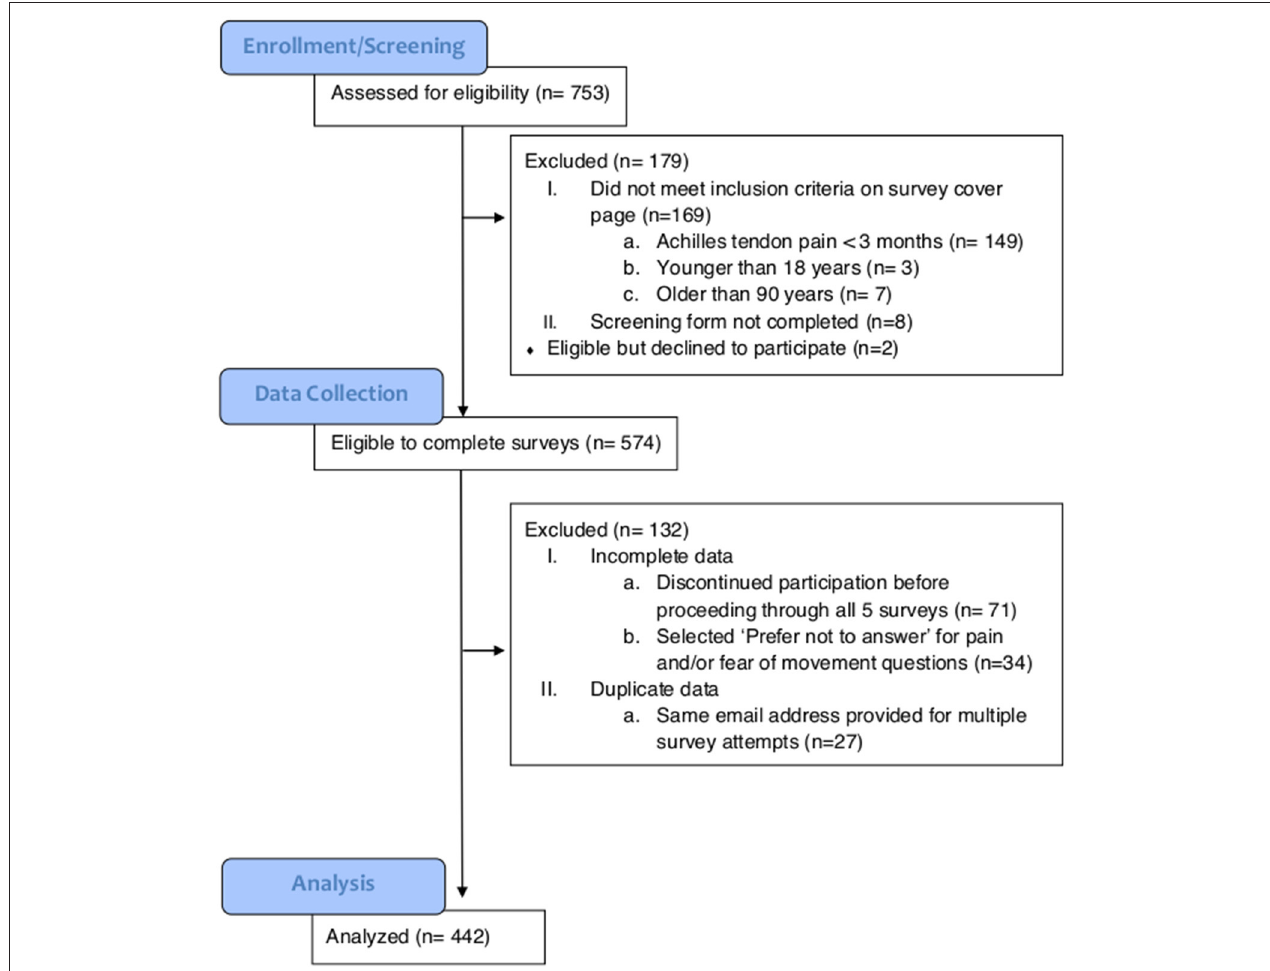
FIGURE 1 | CONSORT diagram indicating the number of individuals at enrollment, data collection, and